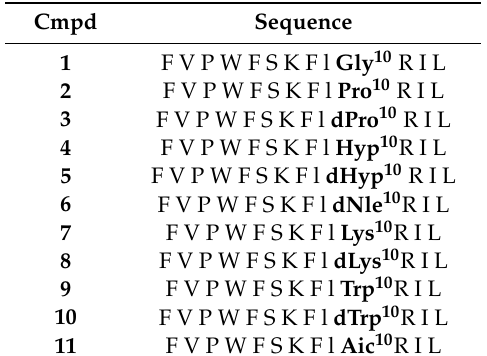
Table 5. Sequences of compounds used in our study reported in Merlino et al. [13].